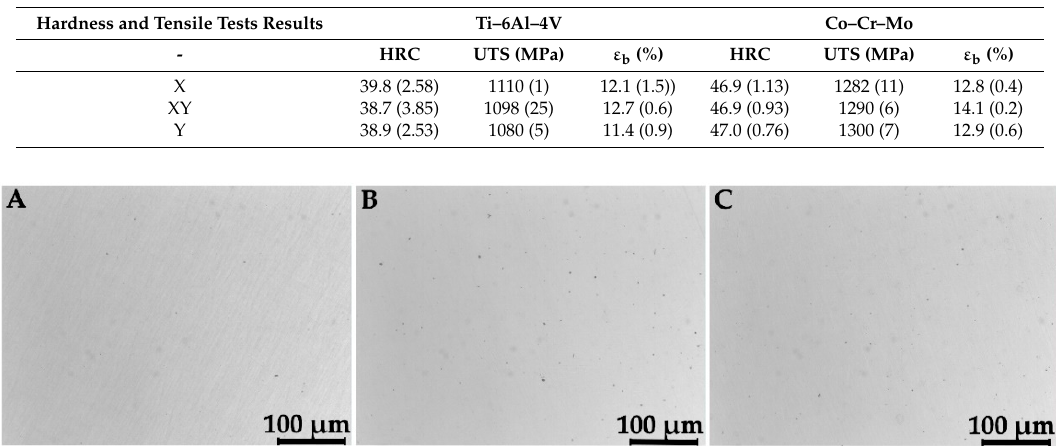
Table 4. Results of the hardness and tensile tests. Standard deviations are given in brackets next to the mean values.